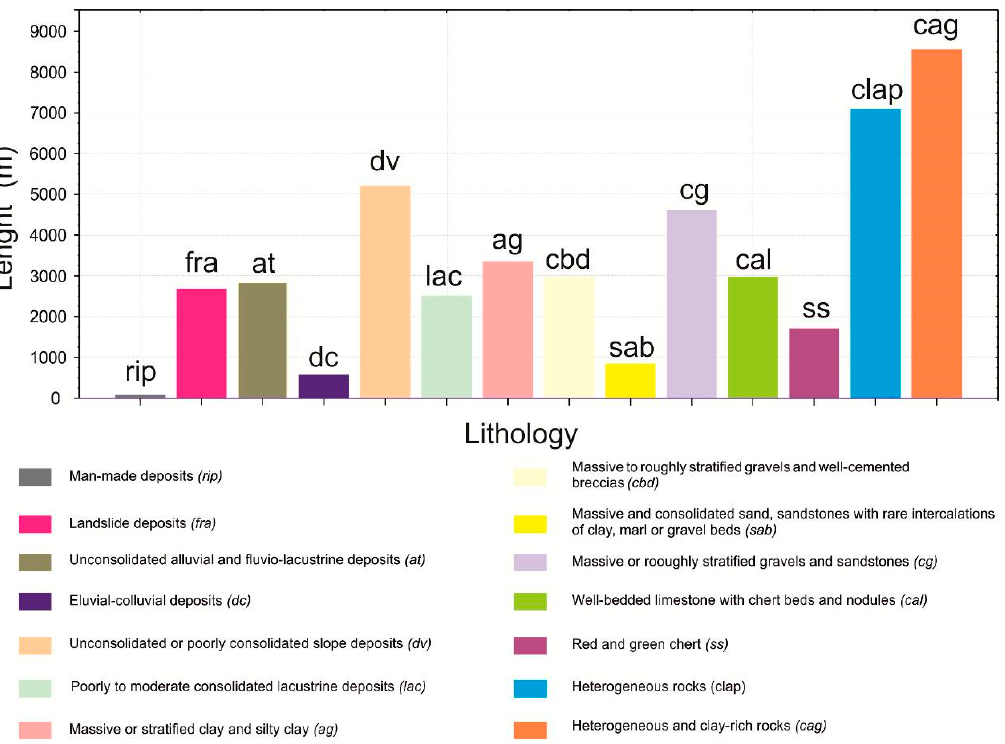
Figure 5. Histogram showing the cumulative length distribution of the segment of the Via Herculia for the different lithological units of the study area. Please note that the relative maxima of the diagram are represented by heterogeneous lithological classes (see text for explanation).